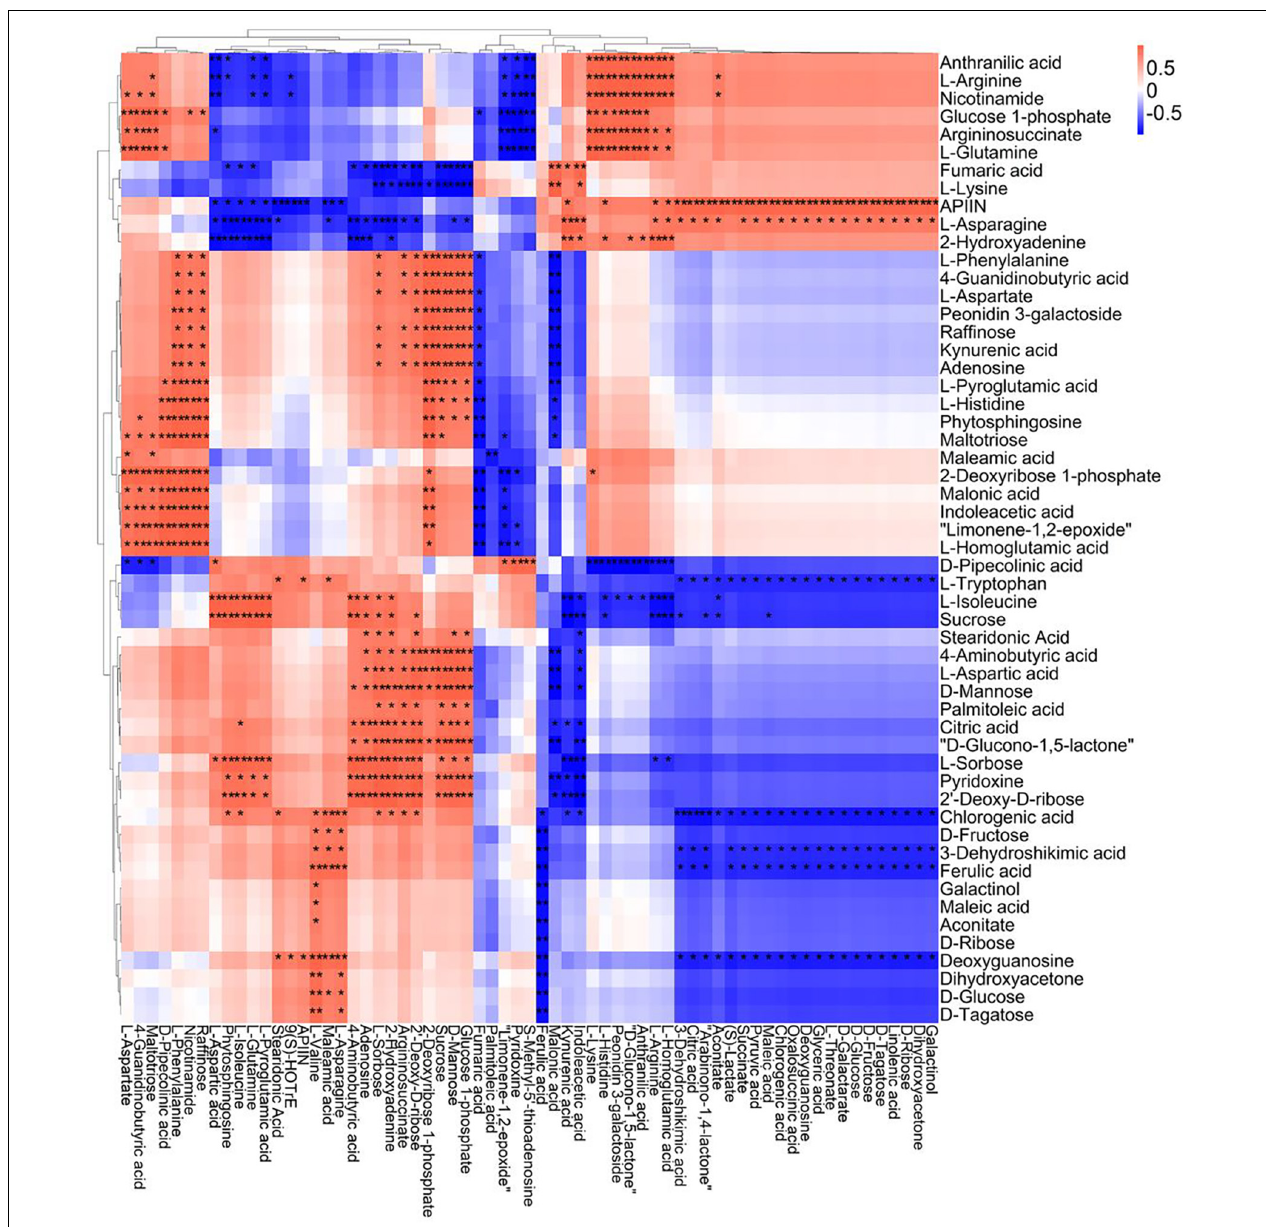
FIGURE 9 | Correlation analysis of TS-DN6 leaf metabolites subjected to spaceflight treatment. A correlation matrix was generated using Pearson’s correlation on six biological replicates of CK and SP-treated plants. Red color shows positive correlation whereas blue color represents negative correlation among the metabolites under spaceflight treatment. ** and * indicate significant difference at p < 0.01 and p < 0.05 by Pearson’s correlation test,